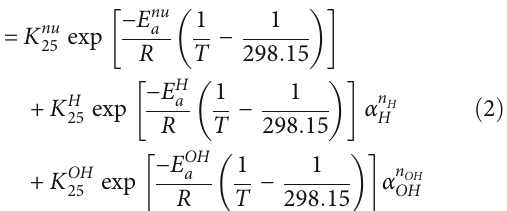
Table 2: Hydrogeological and thermodynamical parameters used in the simulation (Note: S liquid saturation).